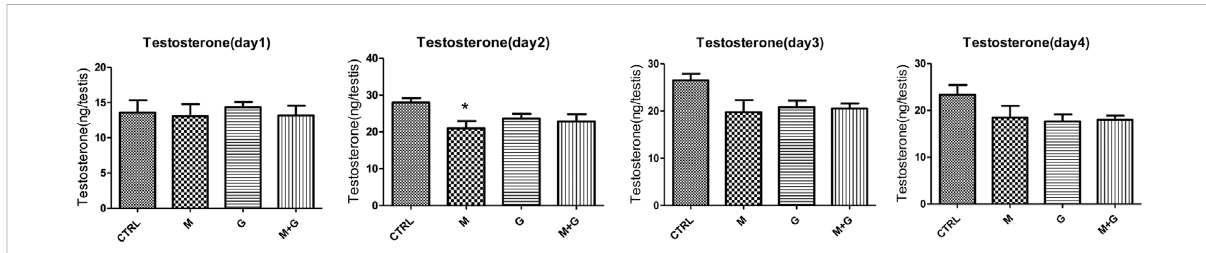
FIGURE 7 Testosterone concentration analysis. *, signi fi cantly different from CTRL at p < 0.05.